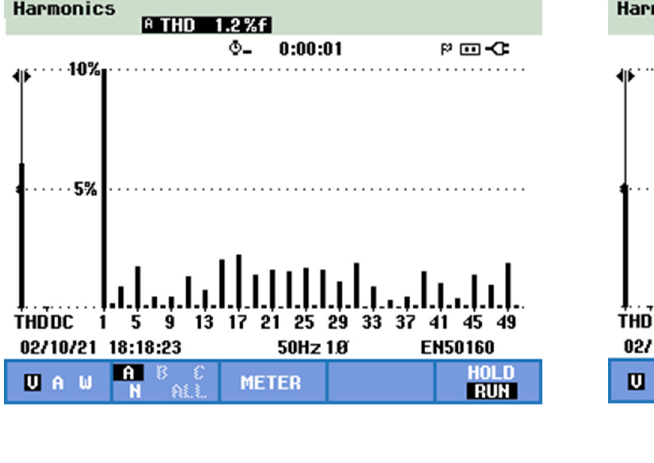
Figure 14. Output voltage and current waveforms at different bandwidth ( h ): ( a ) h = 0.04, ( b ) h = 0.03 and ( c ) h = 0.02. ( a ) ( b ) Figure 15. ( a ) Output voltage, current waveforms and DC link voltage for variable load. ( b ) Output voltage, current wave- forms and DC link voltage for variable DC source voltage. ( a )